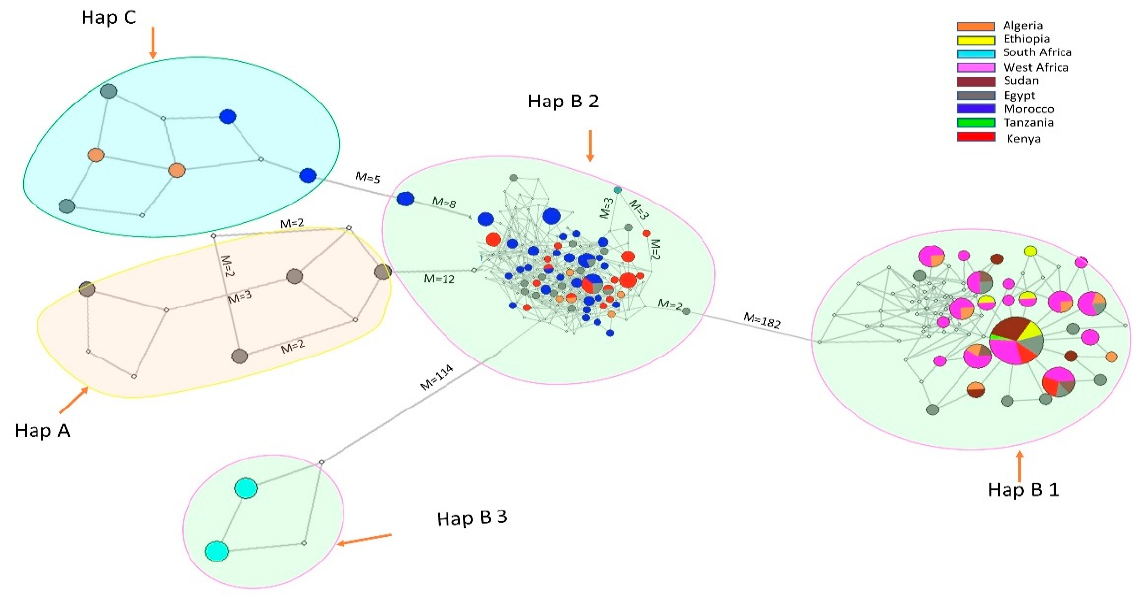
Figure 2. Median-joining network of haplotypes. Circles represent haplotypes, area of the circle is proportional to frequency, colors represent the country, M represents the number of mutations, and links without indicated mutations represent one